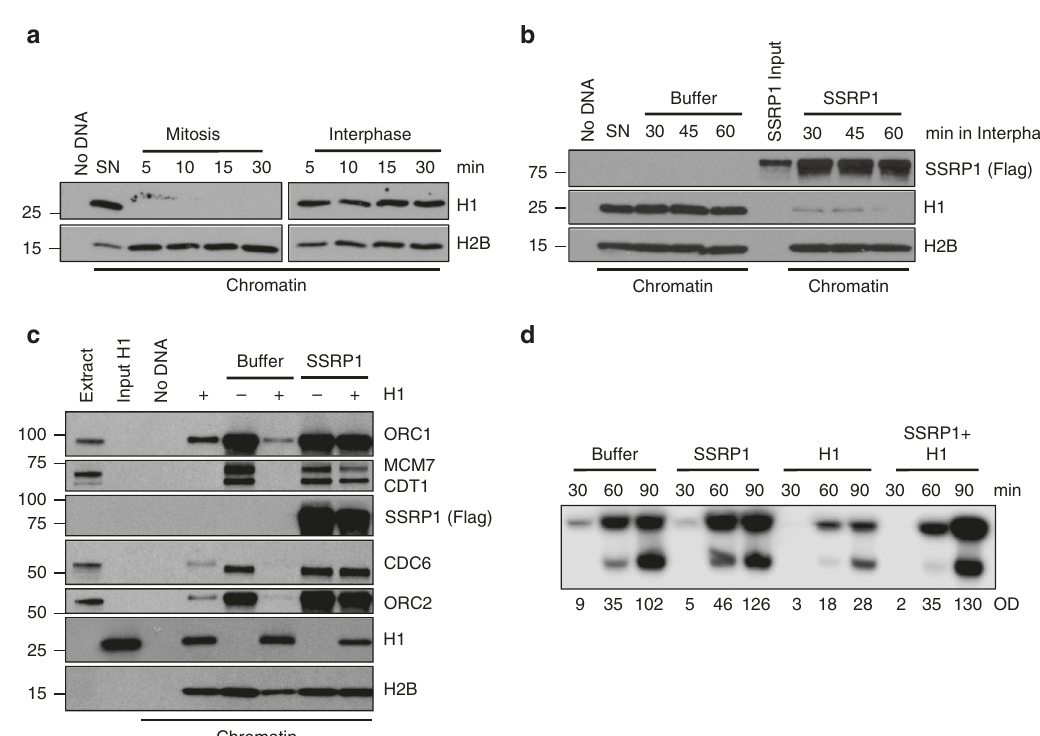
Fig. 3 SSRP1 counteracts histone H1-dependent inhibition of origin assembly. a Western blot (WB) of the indicated proteins bound to chromatin isolated from SN incubated with mitotic or interphase extracts for the indicated times. b WB of the indicated proteins bound to chromatin isolated from SN pre- incubated with 200 ng/ μ l recombinant SSRP1 or control buffer and transferred to interphase extracts for the indicated times. SSRP1 input is 10% of the total. c WB of chromatin isolated from interphase egg extracts supplemented with sperm nuclei pre-incubated with buffer ( − ) or puri fi ed histone H1 ( + )